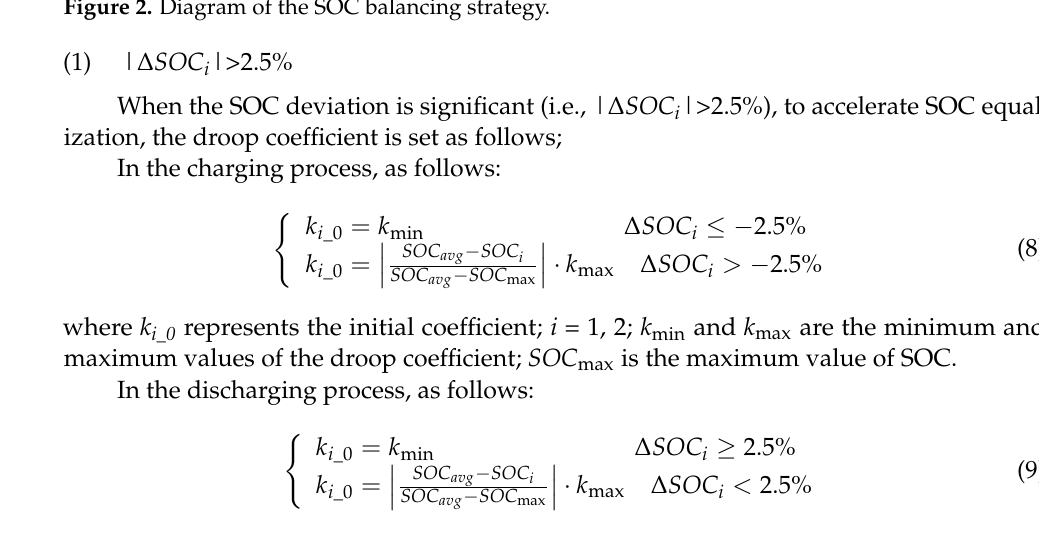
Figure 2. Diagram of the SOC balancing strategy.